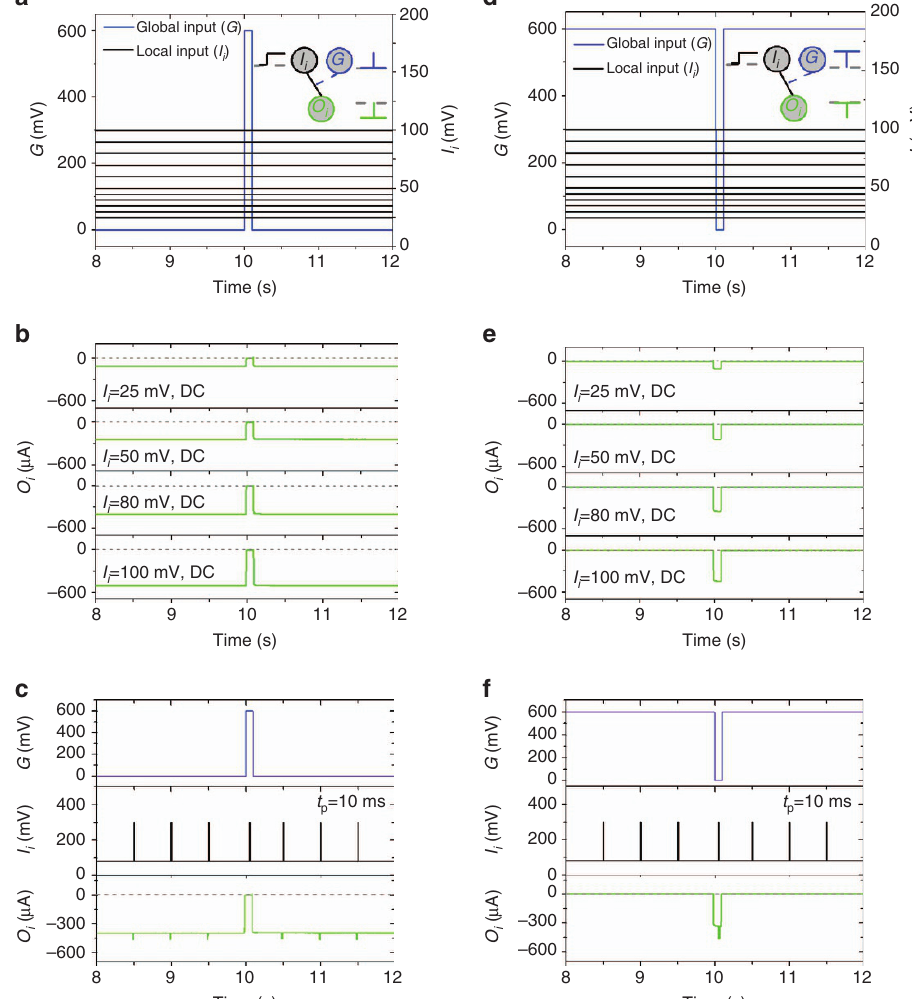
Figure 2 | Synchronization of I/O transmission with a global input. ( a ) Combinations of local and global inputs ( I i : DC voltage 25–100mV, G : pulse of amplitude of 600mV and width of 50ms), and ( b ) resulting outputs, showing that I i / O i transmission shuts down when a voltage pulse is applied at the global input. ( c ) The same pulse shuts down transmission of voltage pulses (amplitude of 220mV, offset of 80mV, width of 10ms) applied at the local input. ( d ) Combinations of local and global inputs, now with an inverted pulse as the global input, and ( e ) resulting outputs showing that transmission is enabled during the inverted pulse. ( f ) The same pulse now enables transmission of local